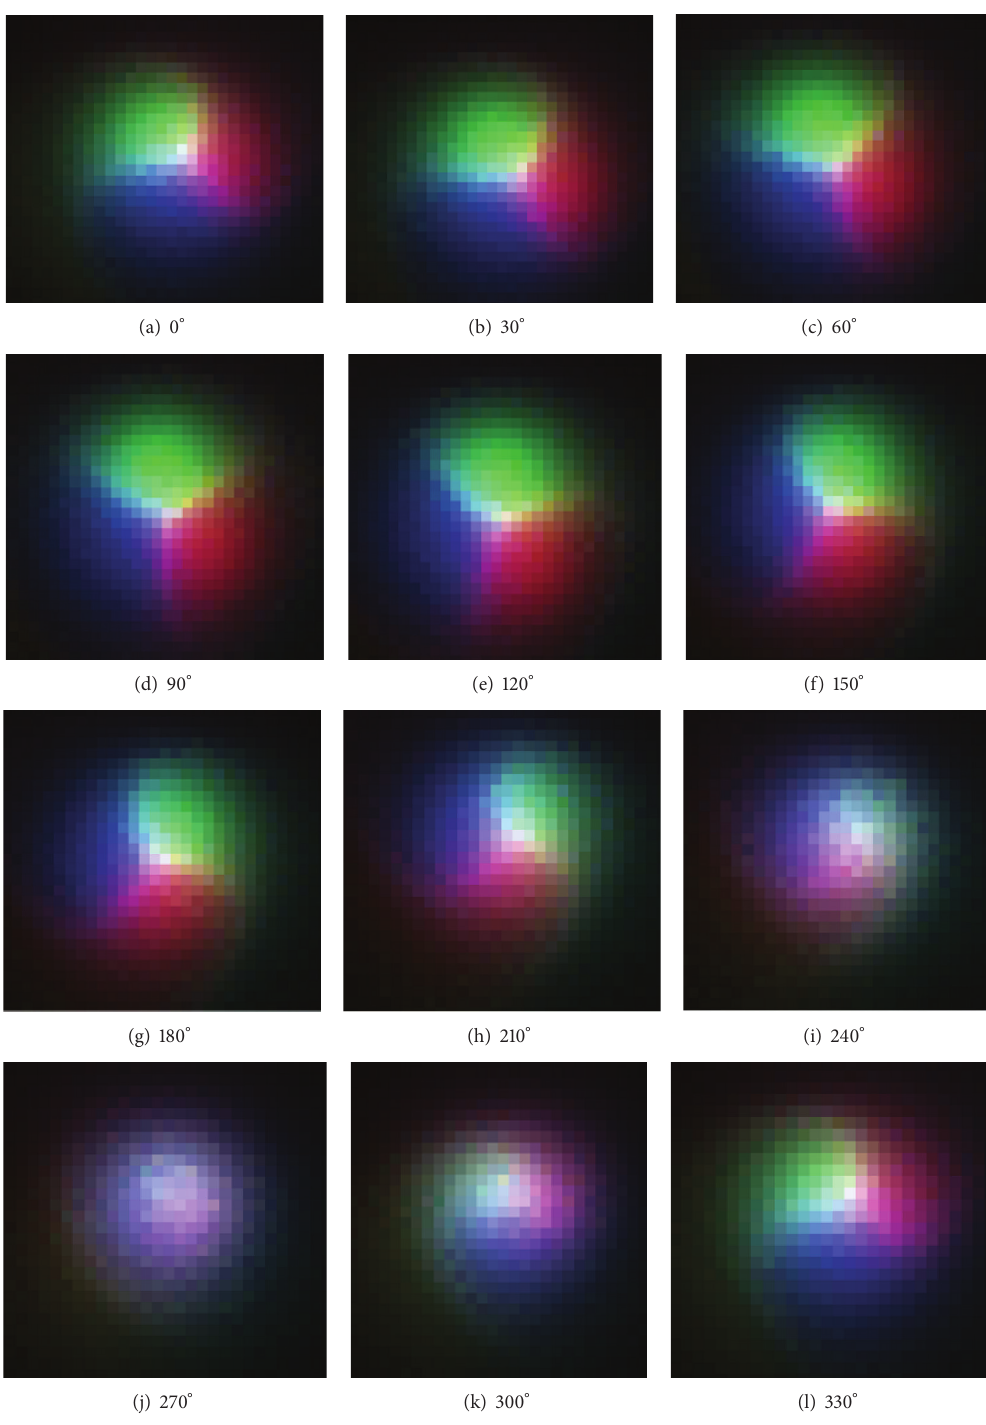
Figure 17: Modeled output color mixing when crank is rotated from 0 ∘ to 360 ∘